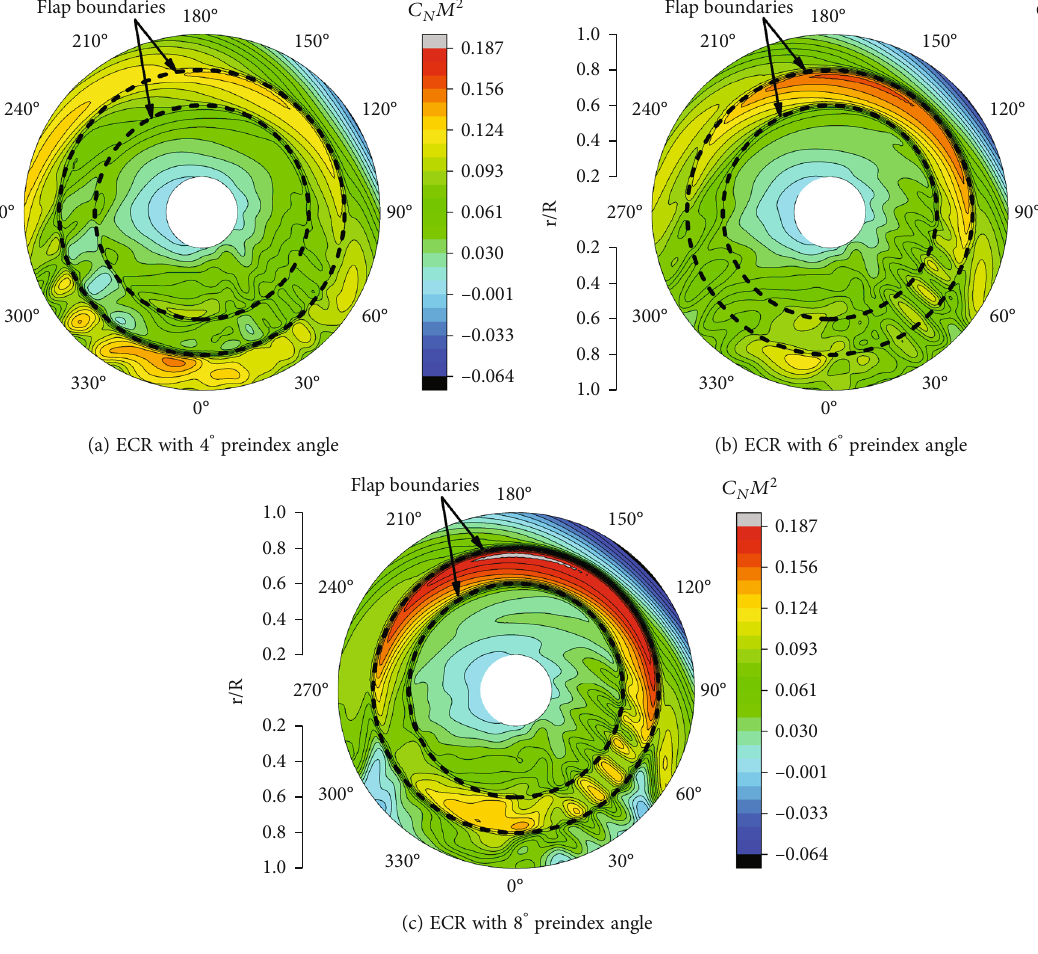
Figure 8: Disc airload distribution of the